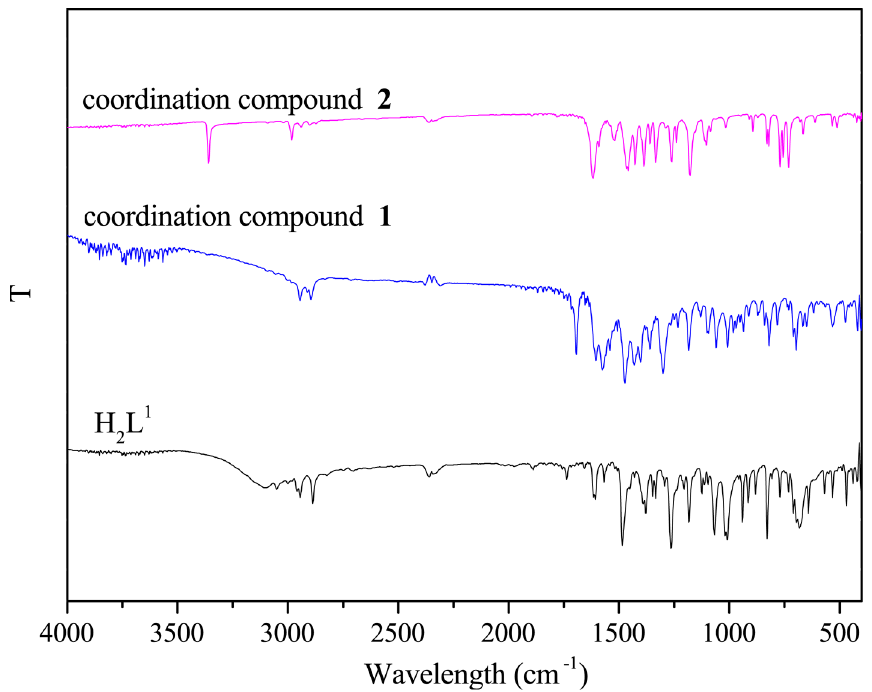
Figure 1. Infrared spectra of H 2 L 1 and its coordination compounds 1 and 2 .